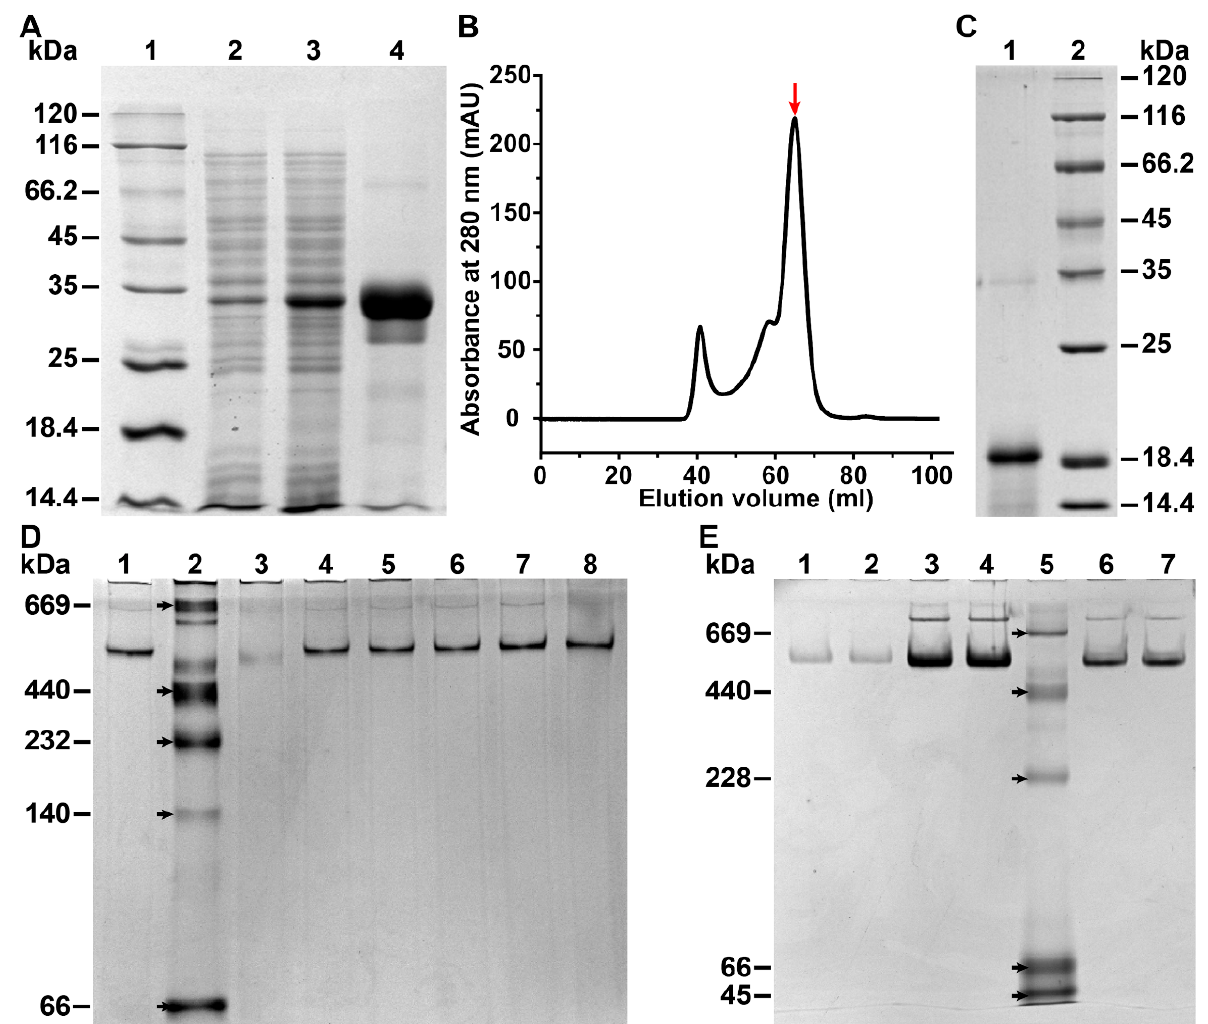
Figure 1. ( A ) Analysis of recombinant DzFer using SDS-PAGE. Lane 1: middle molecular weight markers; lane 2: negative control without induction of DzFer; lane 3: induced expression of DzFer with final IPTG concentration of 0.5 mM for 18 h at 18 °C; lane 4: purified recombinant DzFer with the SUMO tag. ( B ) Superdex 200 gel-filtration chromatography profile of DzFer, where the target protein is shown by a red arrow. ( C ) SDS–PAGE profile showing an approximate molecular weight of 20 kDa. Lane 1: purified DzFer without the SUMO tag; lane 2: middle molecular weight markers. ( D ) Native-PAGE analysis of DzFer at varying pH conditions (pH 2–12). Lane 1: DzFer; lane 2: protein markers; lanes 3–8: pH conditions of DzFer in the following order: pH 2, pH 4, pH 6, pH 8, pH 10, and pH 12. ( E ) Native-PAGE analysis of DzFer, Ag + -DzFer, and Cu 2+ -DzFer proteins. Lanes 1–2: DzFer; lanes 3–4: Ag + -DzFer protein; lane 5: protein markers; lanes 6–7: Cu 2+ -DzFer protein.